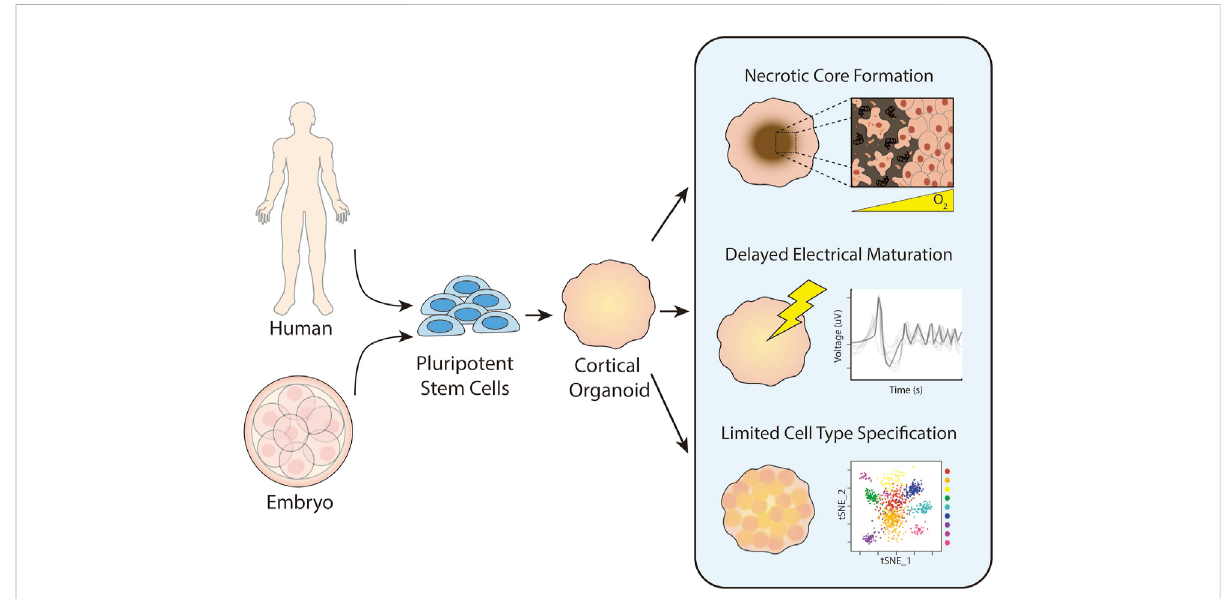
FIGURE 1 Historic challenges in cortical organoid culture. Cortical organoids are generated from pluripotent stem cells harvested from an embryo or reprogrammed from somatic cells. Upon prolonged culture, cortical organoids commonly form necrotic cores due to insuf fi cient distribution of oxygenandnutrients.They alsoexhibitdelayedelectricalmaturationwithspontaneousactionpotentials occurringonlyaftermonthsofculturewith minimal improvement over time. Finally, cortical organoids have limited cell type speci fi cation and differentiation after prolonged